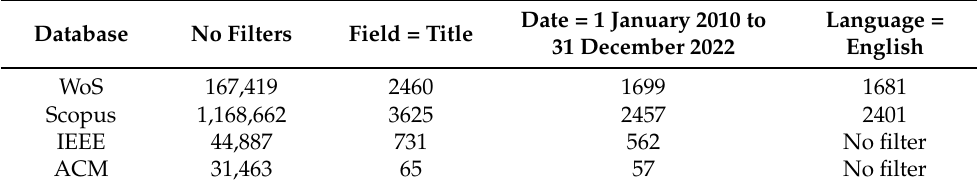
Table 1. Filtering process. The search query in Listing 1 was used across four different databases, and three filters were applied to decrease the initial high number of results.